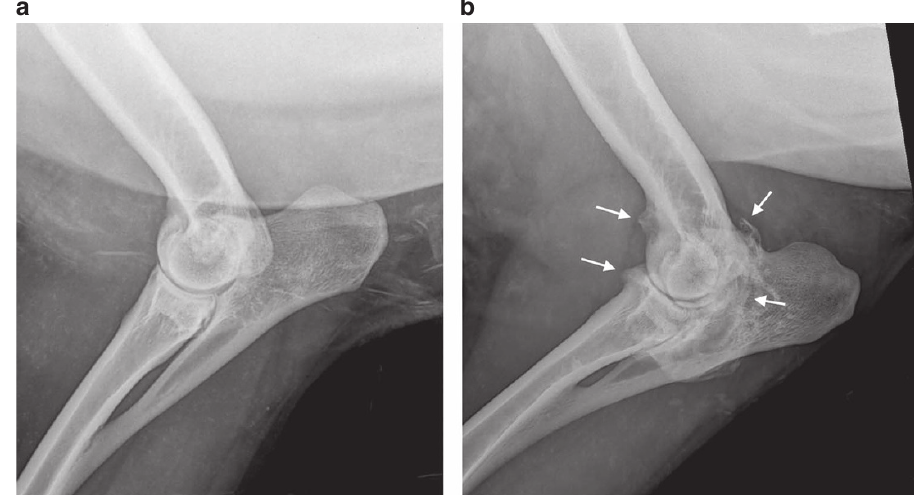
Figure 5 | Mediolateral radiographic views of the elbow joint of two clones with and without osteoarthritis. ( a ) The elbow joint of Clone 388 appears normal: there is no radiographic evidence of osteoarthritis. ( b ) The elbow joint of Clone 2262 shows evidence of severe osteoarthritis. Large osteophytes representing new bone formation are apparent at the joint margins (white arrows), and are associated with bone remodelling. This elbow was scored as Grade 3 on the modified scale of Kellgren and Lawrence 40